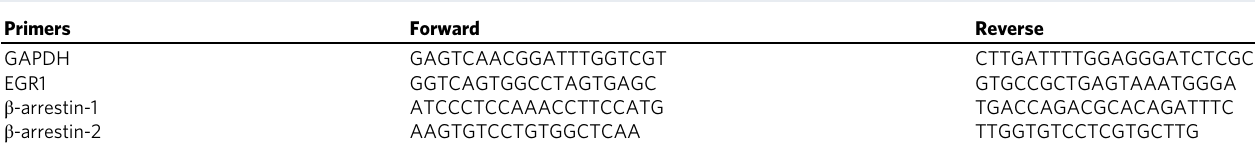
Table 3 RT-qPCR primer